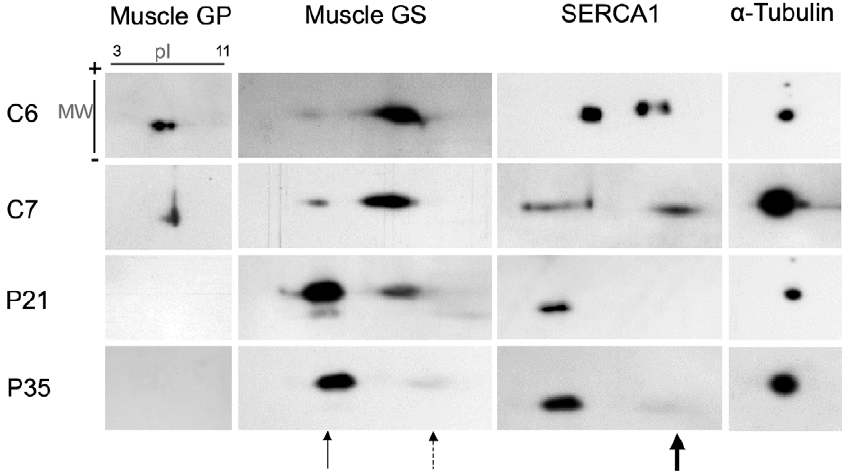
Figure 3. 2D gel analysis of muscle GP, muscle GS, SERCA,1 and a -tubulin in 2 controls and 2 patients. In the first dimension, isoelectric focusing separated proteins by pH 3–11. In the second dimension, proteins were separated by molecular weight. Abbreviations: pI, isoelectric point; MW, molecular weight. Patients P21, P35; Controls C6, C7. Thin arrow indicates acidic muscle GS, discontinuous arrow indicates basic muscle GS and thick arrow indicates basic